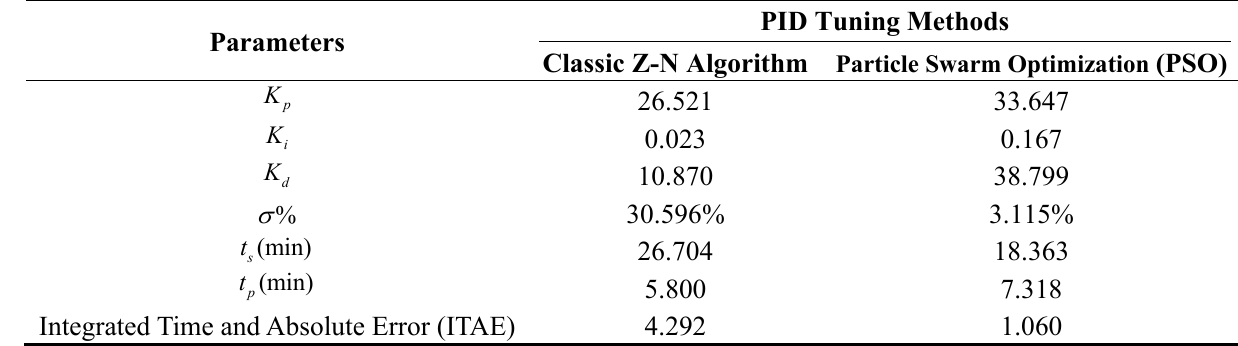
Table 3. Tuning proportional-integral-differential (PID) parameters using the Ziegler-Nichols method in comparison with the particle swarm optimization